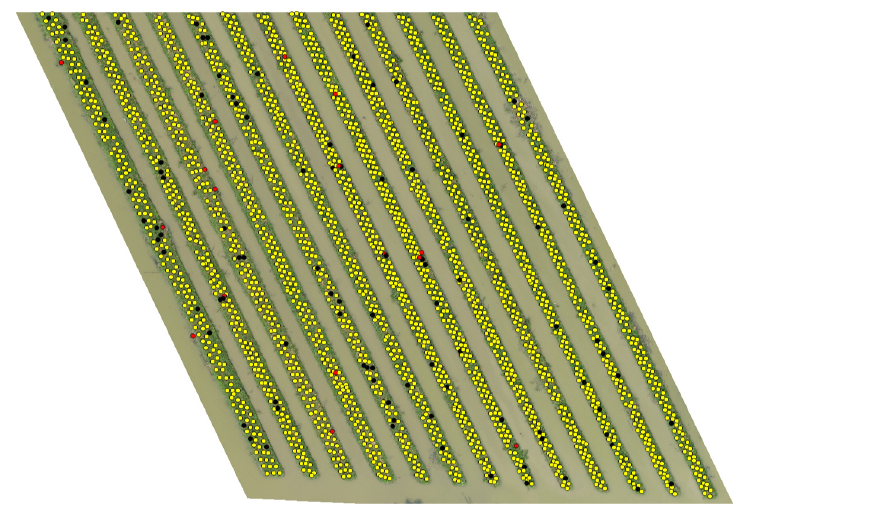
Fig 8. Final detection on ROI of 40m altitude variant.